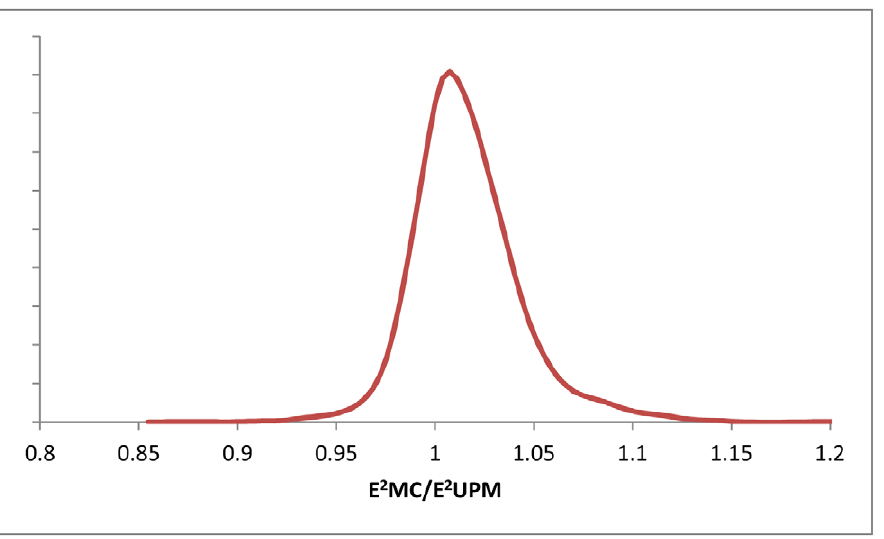
Figure 3. The distribution of the E 2 MC,k / E 2 UPM,k ratios for 2294 gene families. The curve was smoothed using the Gaussian-kernel method.